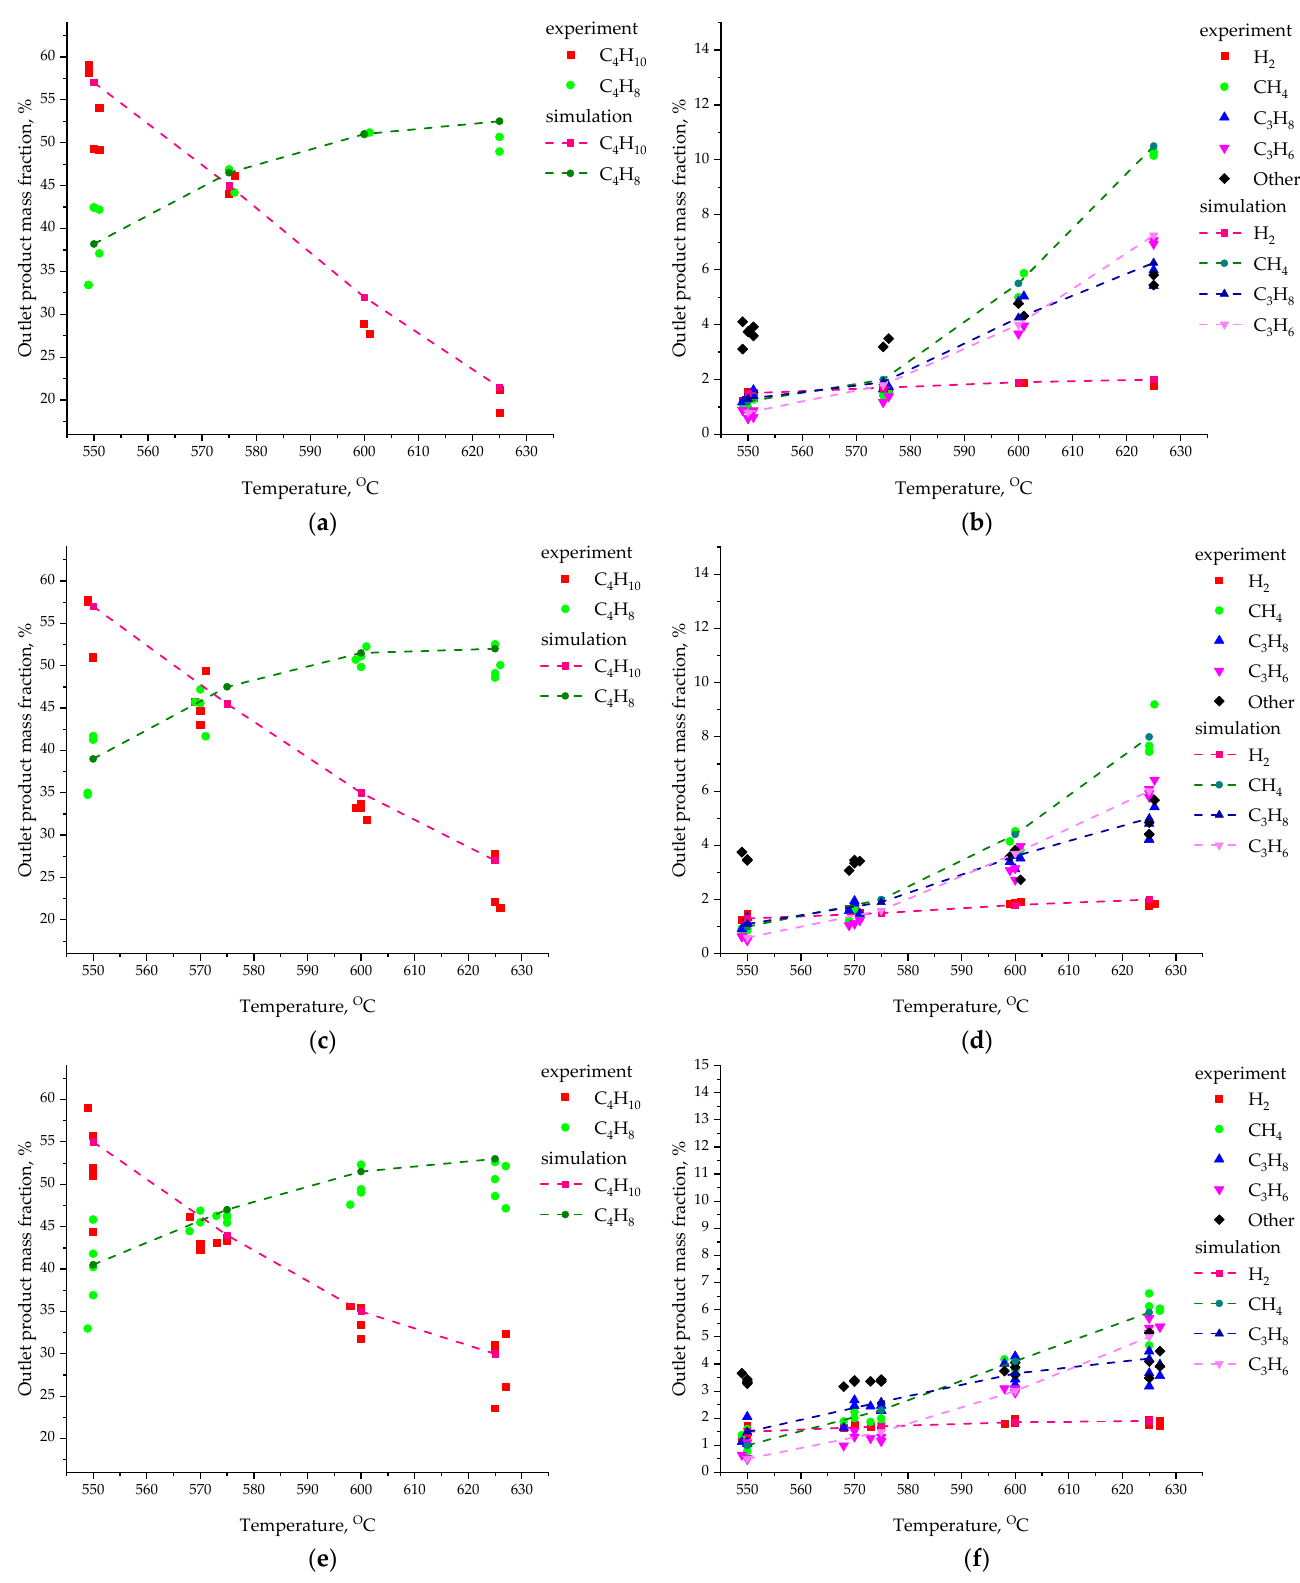
Figure 7. The mass fraction of reaction products for the case of catalyst mass of 75 g: ( a ) C 4 H 10 and C 4 H 8 at v = 0.008 m/s; ( b ) H 2 , CH 4 , C 3 H 8 , C 3 H 6 at v = 0.008 m/s; ( c ) C 4 H 10 and C 4 H 8 at v = 0.012 m/s; ( d ) H 2 , CH 4 , C 3 H 8 , C 3 H 6 at v = 0.012 m/s; ( e ) C 4 H 10 and C 4 H 8 at v = 0.016 m/s; and ( f ) H 2 , CH 4 , C 3 H 8 , C 3 H 6 at v = 0.016 m/s.